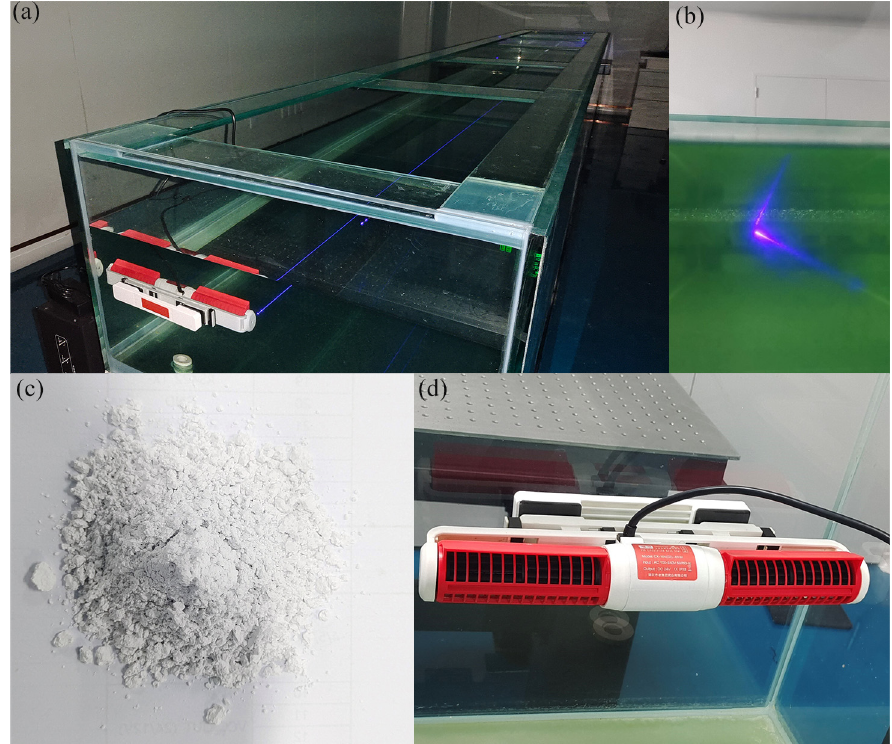
Figure 5. The simulated underwater channel: ( a ) the water tank, ( b ) the view of the received optical spot in the water, ( c ) Mg(OH) 2 powder, ( d ) the wave-making air pump.